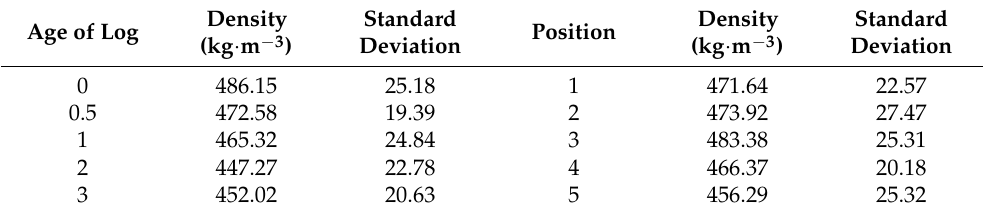
Table 2. Average density values for individual groups according to age of log and position.